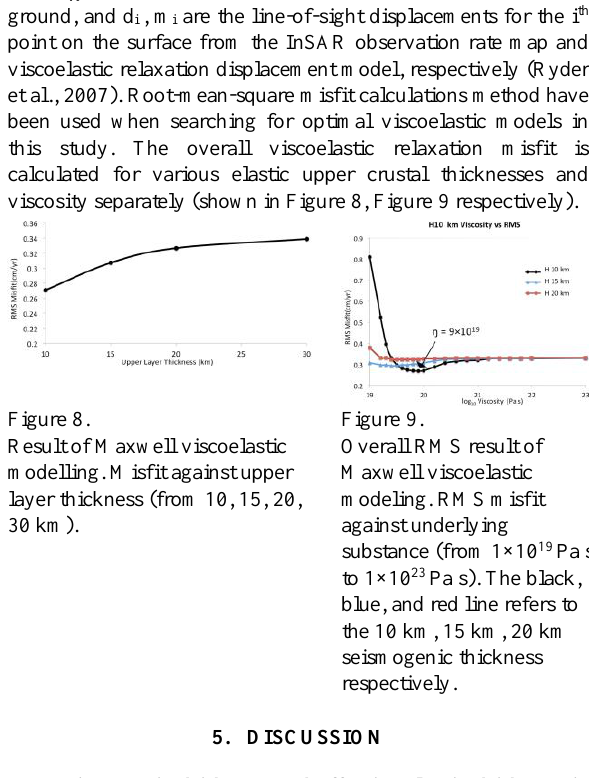
Figure 8. Result of Maxwell viscoelastic modelling. Misfit against upper layer thickness (from 10, 15, 20, 30 km).